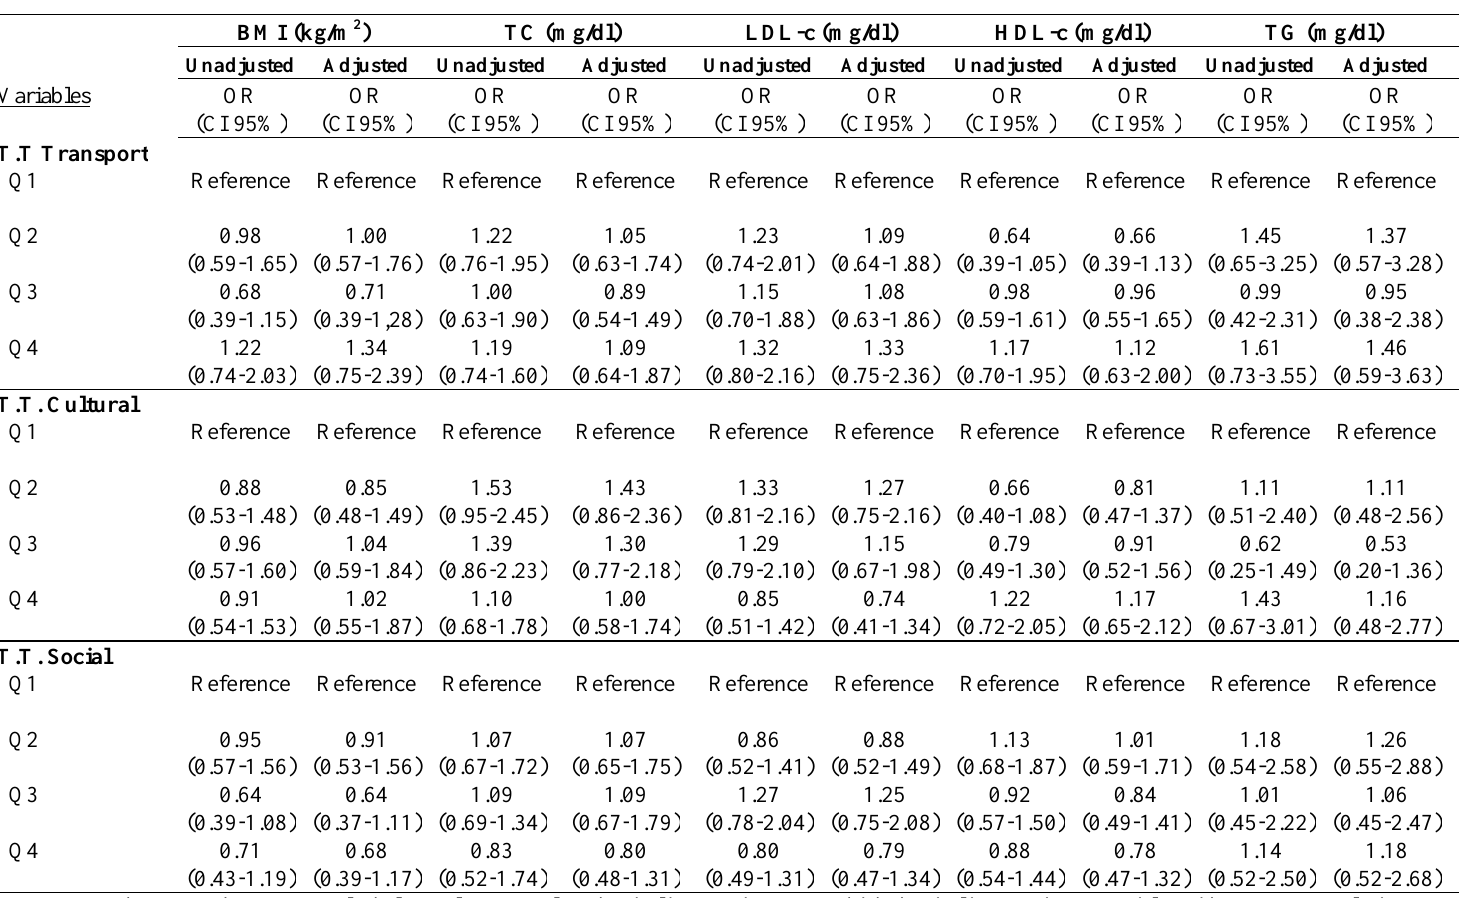
BMI = Body Mass Index; TC= Total Cholesterol; LDL-c= low density lipoprotein; HDL-c=high density lipoprotein; TG= triglycerides; T. T. = Total Time; OR= Odds Ratio; CI= Confidence Interval. *p ≤ 0.05. Values adjusted for sex, age group, SES, MVPA, food risk and all sedentary behavior